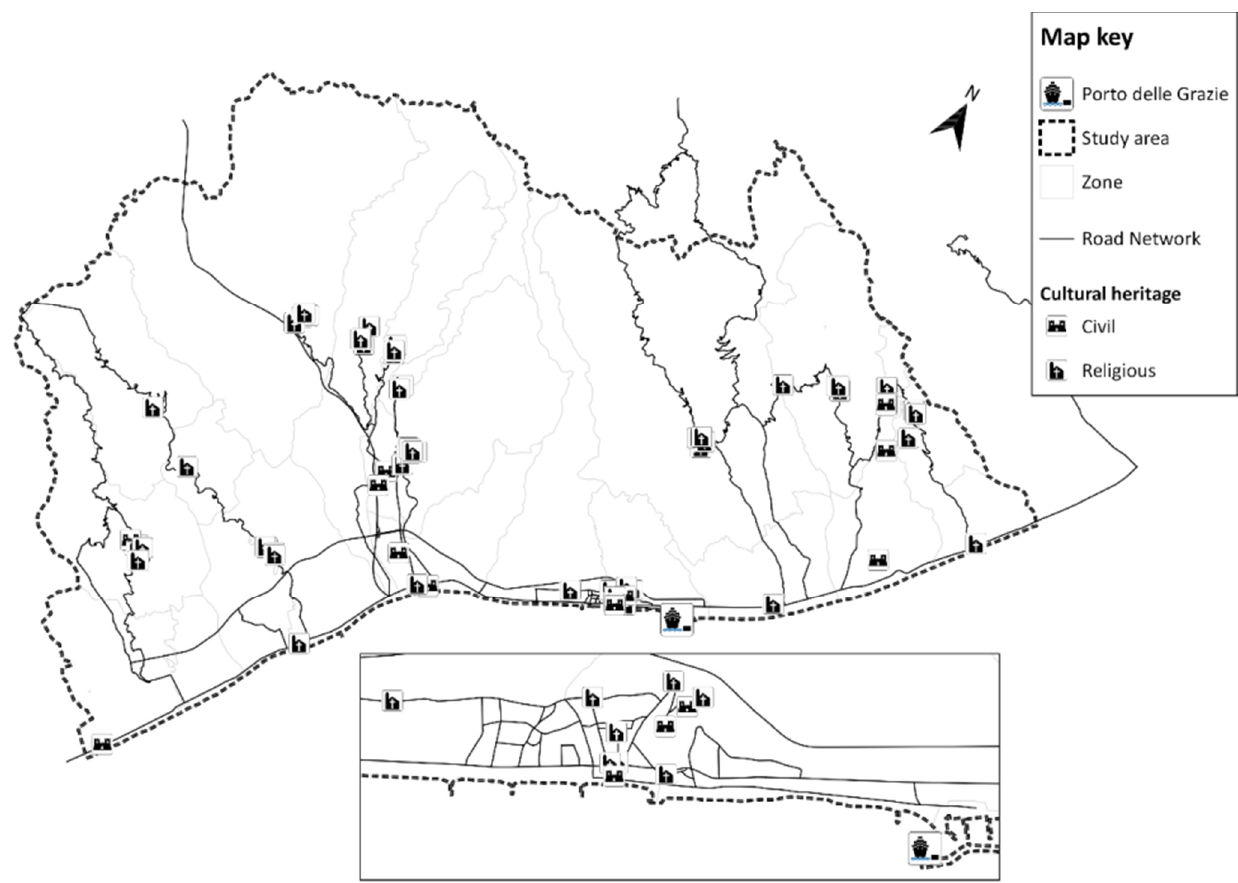
Figure 2. Study area with the port, the touristic destinations and the road network. The analysis concerns the energy consumption of electric vehicles (EV), that offer transport services to tourists who arrive at the port and visit the touristic destinations inside the area. During the experimentation, EVs use an electricity charging station located inside the